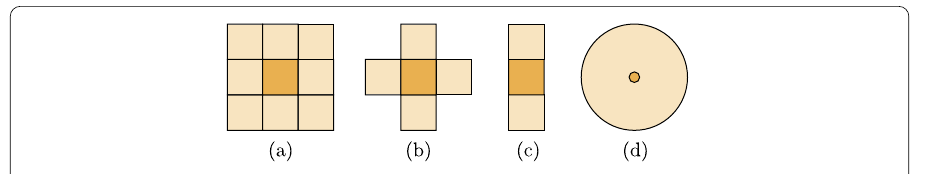
Figure 2 Examples for the shape of a structuring element B : ( a ) Square, ( b ) diamond, ( c ) line segment and ( d ) ball. By the darker shaded areas, the origin of B is described. According to [32]